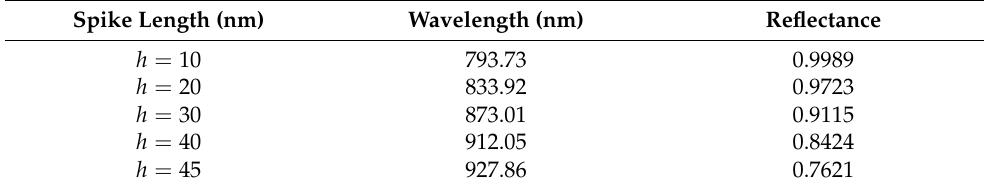
Figure 4. Numerically calculated reflectance spectra for a single COVID-19 particle for five spike lengths h in the range from 10 to 45 nm. The values of the remaining geometric parameters defining the COVID-19 particle were r = 70 nm, D = 8 nm, and N = 147. Table 1. Variations of reflectance characteristic under the manipulation of spikes’